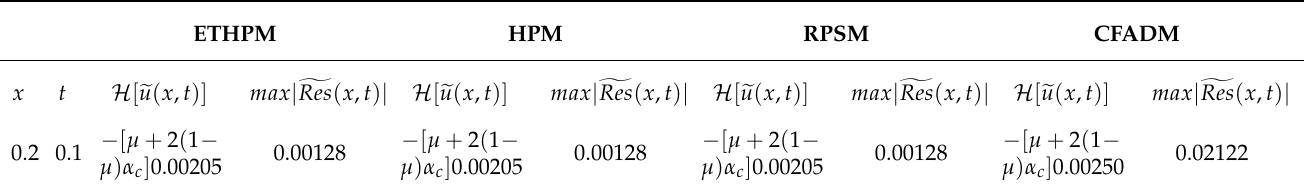
Table 8. H [ (cid:101) u ( x , t )] and max | (cid:103) Res ( x , t ) | by ETHPM, HPM, RPSM, CFADM for α = 0.75, τ = 0.2, r = 0.25, A = 1, B =